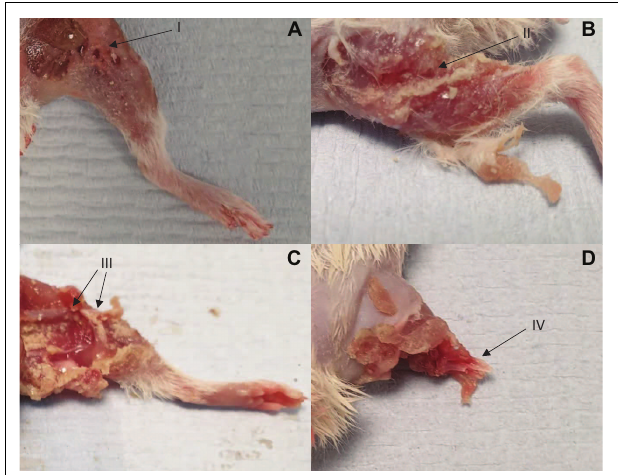
FIGURE 5 | Four separate injuries of worsening severity sustained following impact with high velocity sand blast. (A) Burst lacerations and skin tears seen at I. (B) Involvement of the underlying subcutaneous and muscular layers, with muscle tears and stripping seen at II. (C) Associated open segmental femoral fracture seen at III, with extensive surrounding soft tissue damage and loss. (D) Complete limb avulsion with traumatic amputation seen at IV.